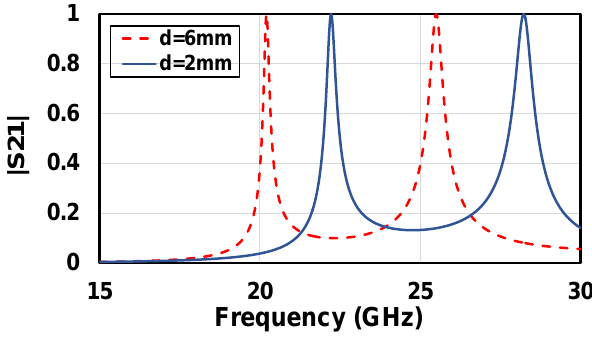
Fig.8. Effect of change in length coaxial cable on magnitude of transmission